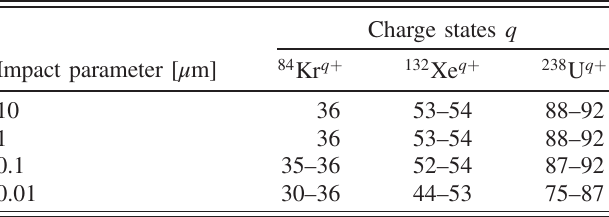
TABLE IV. Dependence of the charge state distribution on the impact parameter. Fully ionized states are 84 Kr 36 þ , 132 Xe 54 þ , and 238 U 92 þ